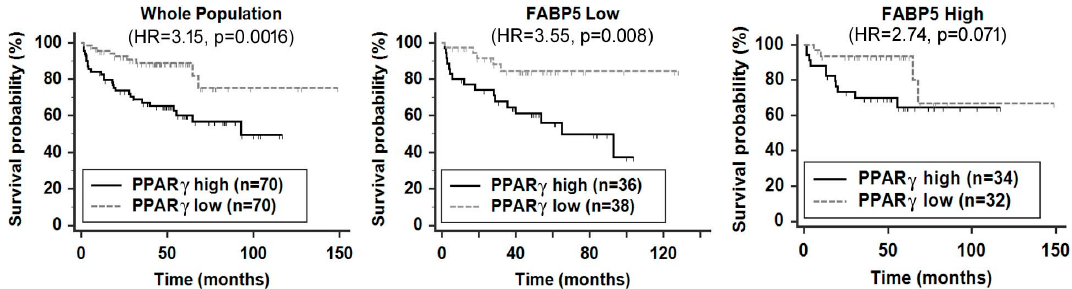
Figure 3. Impact of FABP5 expression on prognostic significance of peroxisome proliferator-activated receptor γ (PPAR γ ) in PCa patients. Log-rank test of Kaplan–Meier patient survival curves was performed using MedCalc (version 14.12.0) and the cut-off point for stratifying the patient population with high or low levels of FABP5 and PPAR γ mRNA was determined by receiver operating characteristic (ROC) analysis using recurrence status as a classification factor. The FABP5 and PPAR γ mRNA levels and patient clinical records were obtained from cBioPortal (http: // www.cbioportal.org / datasets) [44]. n, sample size; HR, hazard ratio; p , statistical significance level.